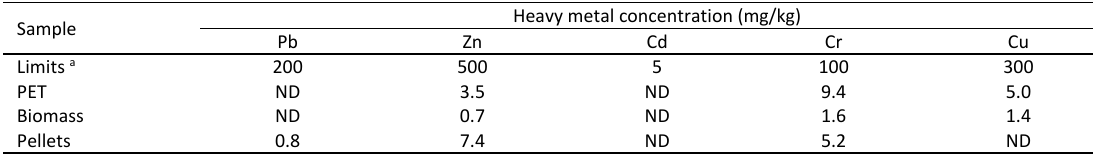
Table 3: The results of heavy metal concentration